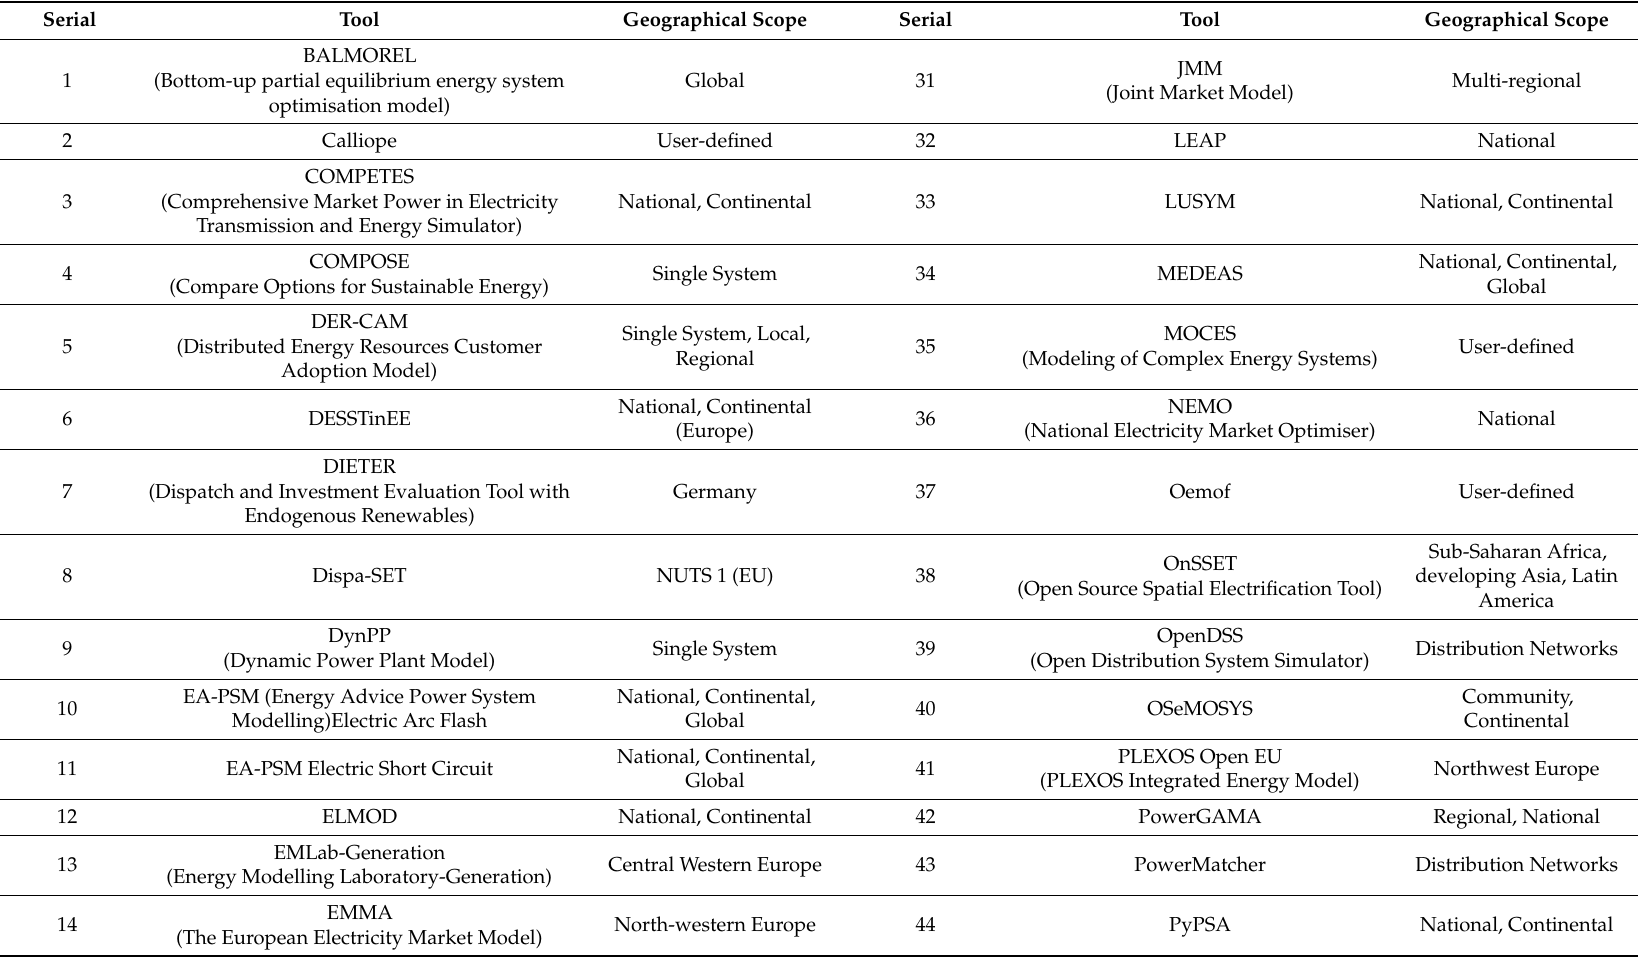
Table A1. Open energy modelling tools. Adapted from [98] and